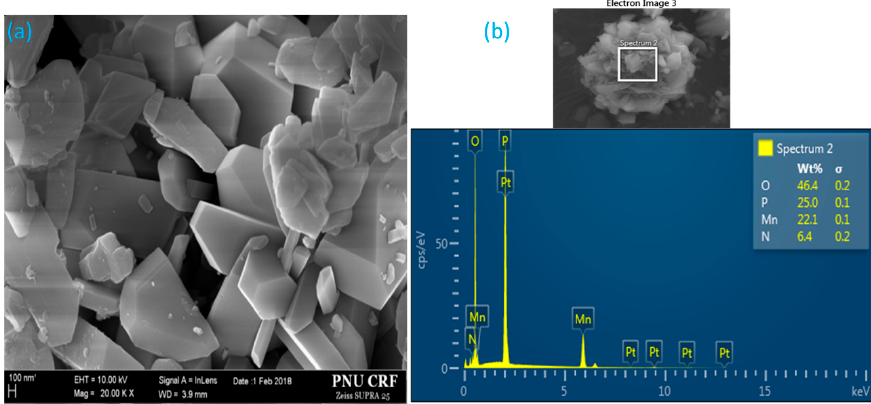
Figure 4. ( a ) SEM micrograph and ( b ) EDX analysis of synthesized manganese violet.